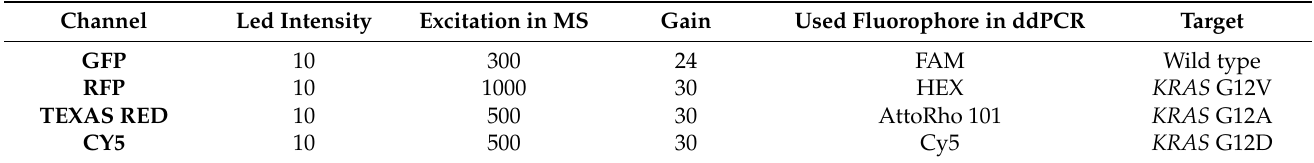
Table 1. Settings for imaging with a Lionheart LX